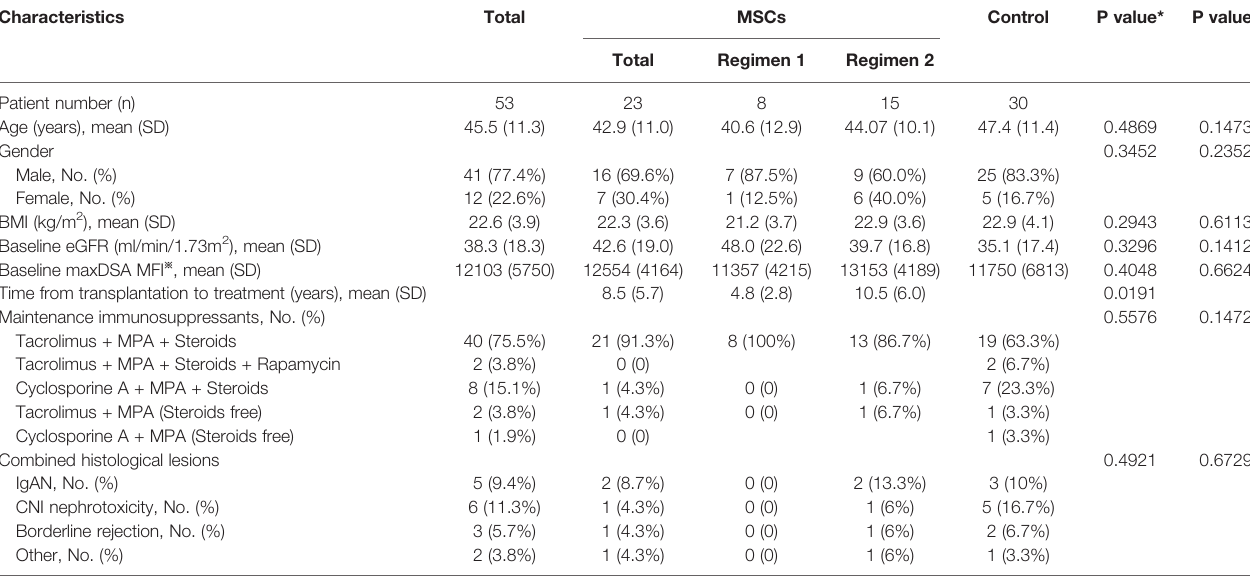
TABLE 1 | Baseline characteristics of chronic antibody-mediated rejection patients before BM-MSCs treatment and the contemporaneous control.